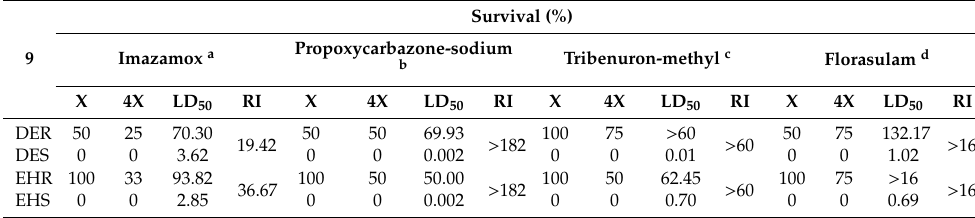
Figure 2. E ff ects of tribenuron-methyl ( a ) and imazamox ( b ) applied post-emergence at increasing rates on the shoot fresh weights of S (open circles) and R (closed circles) Erucaria hispanica populations. Data was collected 21 days after treatment. Table 4. E ff ects of post-emergence treatments on the survival rate of plants from D. erucoides and E. hispanica ALS-sensitive and -resistant populations (DES, DER, EHS, and EHR, respectively). Herbicides were applied at 1 and 4 times the label field rate